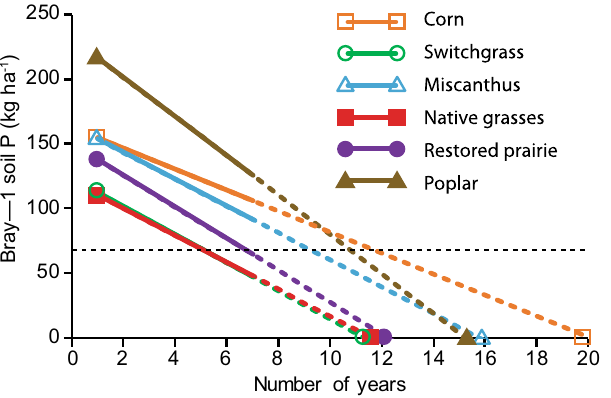
Figure 5. Changes in Bray-1 soil test phosphorus concentration over the years under continuous corn, switchgrass, miscanthus, native grasses, prairie, and poplar. Linear relationships are shown by colored bold regression lines (y = − 2.1607x + 43.357, r 2 = 0.65 for corn; y = − 2.9018x + 32.92, r 2 = 0. for switchgrass, y = − 2.7679x + 43.75, r 2 = 0.74 for miscanthus; y = − 2.7768x + 32.25, r 2 = 0.83 for native grasses; y = − 3.267x + 40.071, r 2 = 0.91 for prairie; y = − 4.0625x + 61.857, r 2 = 0.86 for poplar); while colored dashed regression lines represent predicted change in the STP concentrations when trends beyond 7 years are extrapolated. Black dashed line indicates the critical lower threshold of soil test phosphorus to satisfy crop requirements (68 kg ha −1 , equivalent to 15.0 mg kg −1 ).